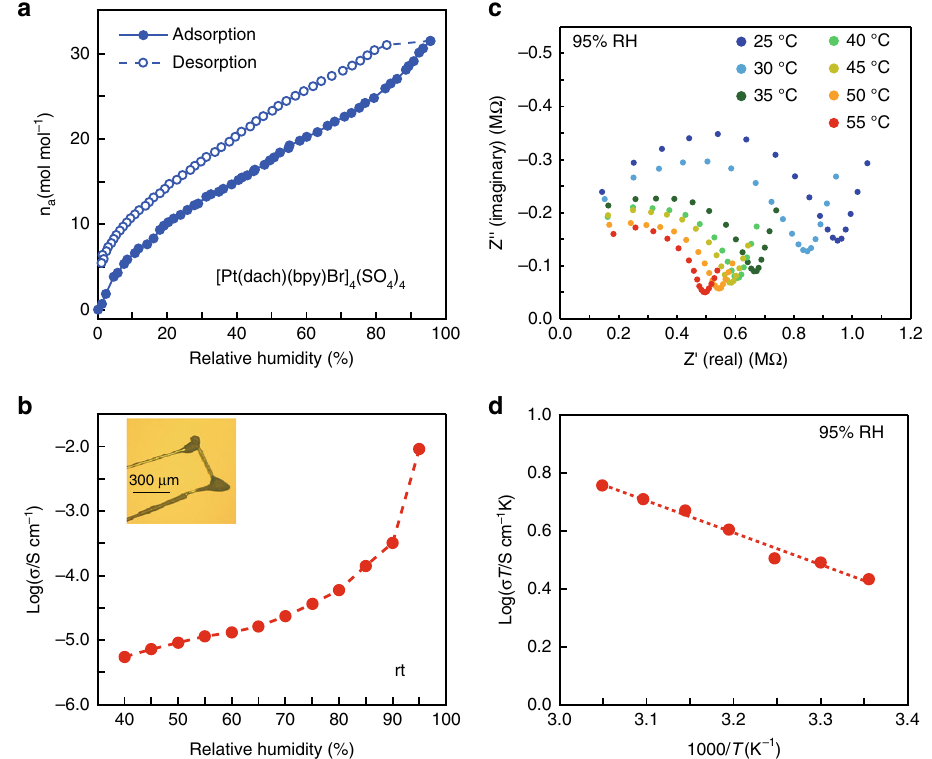
Fig. 3 Humidity dependence of proton conductivity of 1. a Water vapour sorption isotherms (298 K). The blue open and closed circles denote adsorption and desorption processes, respectively. b Humidity dependence of conductivity: Inset shows the experimental setup. c Nyquist plots of 1 at elevated temperature under a relative humidity of 95%. d Arrhenius plots of the conductivity under a relative humidity of